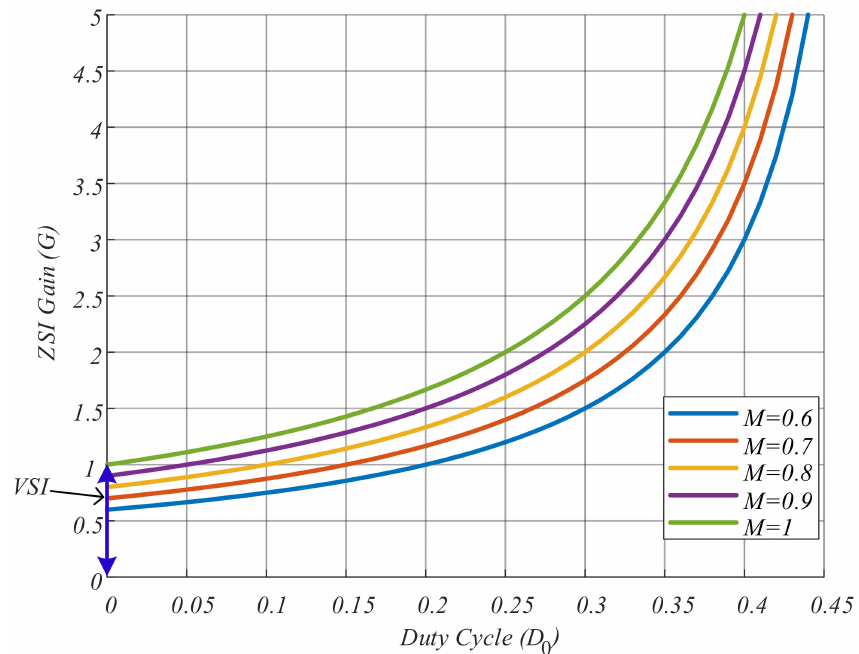
Figure 4. Gain of Z-source inverter based on D 0 and M .